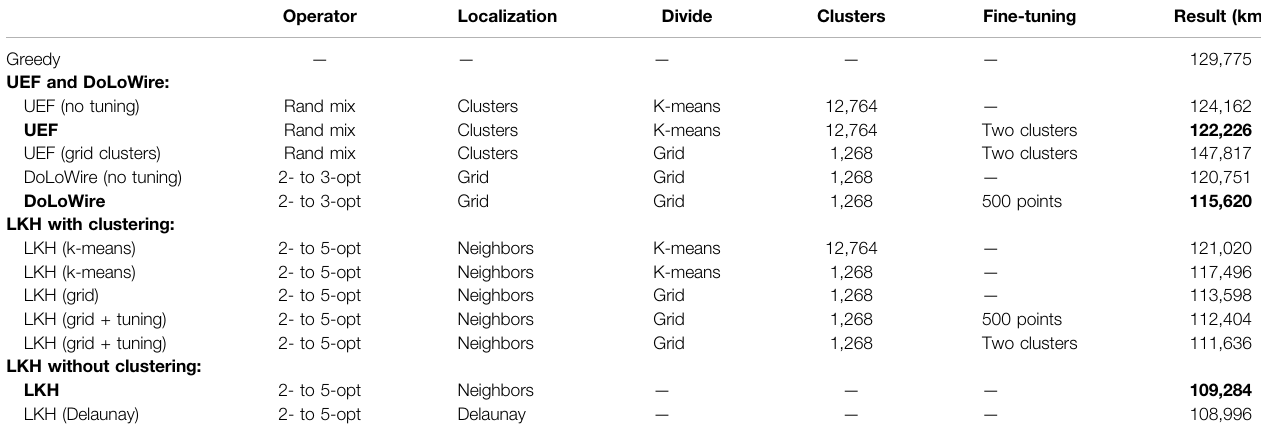
TABLE 2 | Summary of the results. The baselines of the three submitted methods are in